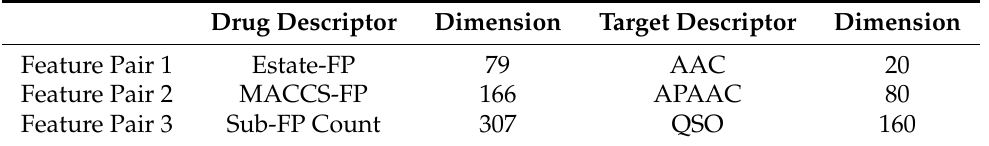
Table 2. Feature Pairs used in Ensemble-MFP.